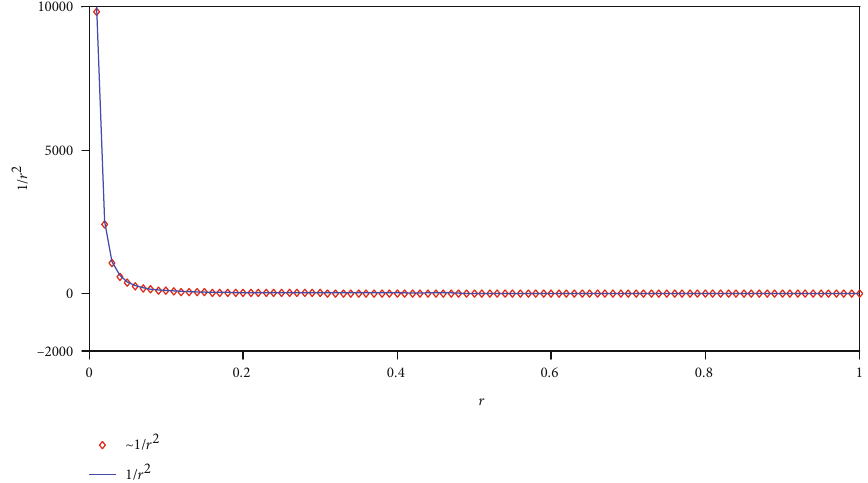
2 diatomic molecule.